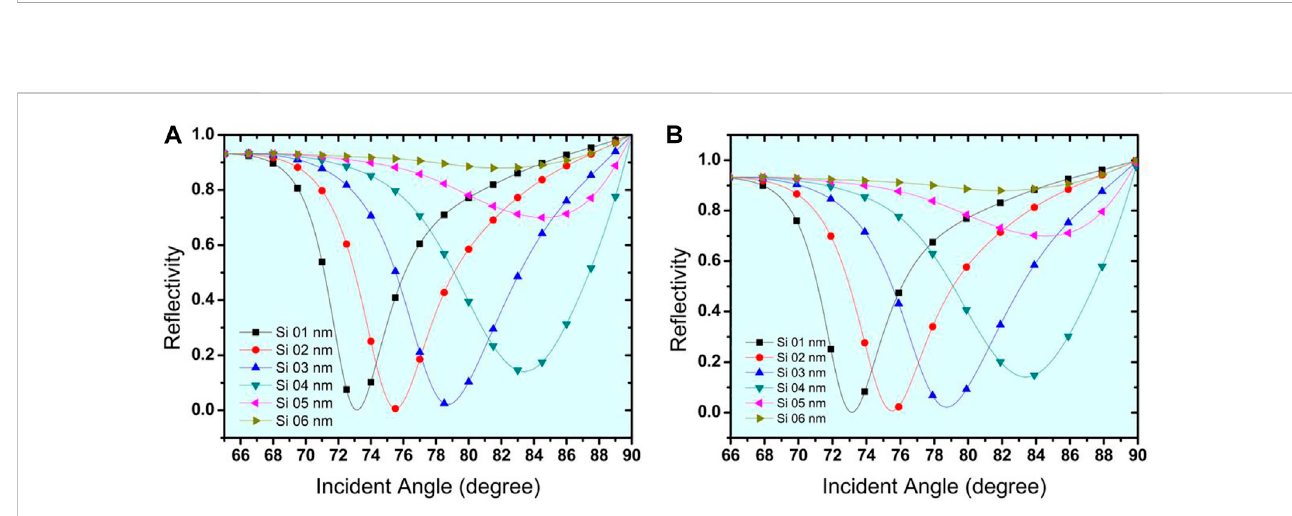
FIGURE 4 Thickness optimization of Si layer for the (A) . Structure-I (Prism/Ag/Si/Bio-sample) (B) . Structure-II (Prism/Au/Si/Bio-sample).